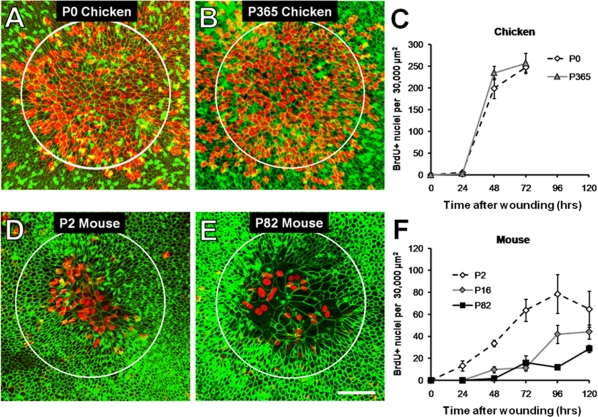
Within closed wounds, more avian supporting cells incorporate BrdU compared to those from mice.(A–B) Z-projected confocal image stacks (20×/0.75NA objective) of the wound area in utricles from P0 and P365 mice fixed after 72 hours of culture (48 hours after wound closure). The apical outlines of supporting cells are visible with phalloidin labeling of F-actin (green). Many supporting cells within the closed wound (initial wound size shown with white circles) have incorporated BrdU (red). (C) Quantification of the number of BrdU+ nuclei in the 30,000 µm2 wound area versus time in chickens. The number of BrdU+ nuclei increases between 24 and 48 hours after wounding, then begins to level off by 72 hours. (D–E) Confocal images of the wound area in utricles from P2 and P82 mice taken after 72 and 120 hours of culture, respectively (48 hours after wound closure). Scale bar in D, 50 µm. (F) Quantification of the number of BrdU+ nuclei in 30,000 µm2 wound areas as a function of time in P2, P16, and P82 mice. In all age groups, the number of BrdU+ nuclei increases between 24 and 48 hours after wound closure.